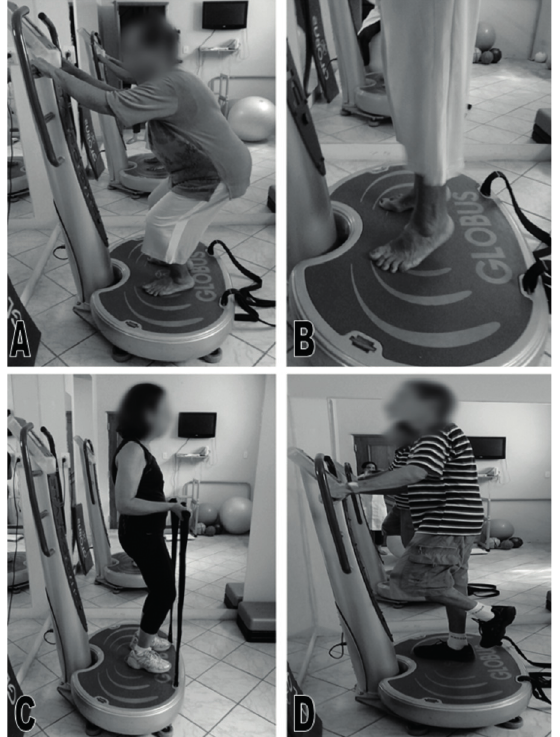
Figure 1 - Exercises held in vibration platform: A – Squat; B – plantar flexion; C – isometric contraction of members and D – single-leg balance Source: Research data.